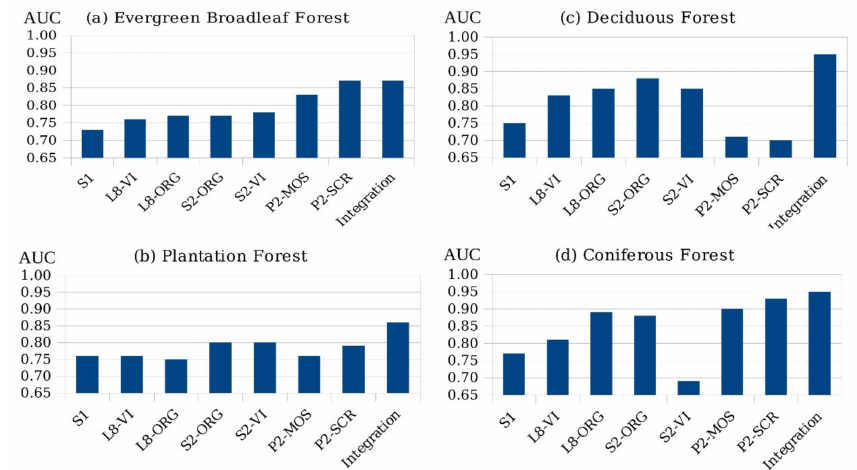
Figure 5. Comparison of the area under the curve (AUC) value of input data in forest classes. ( a ) The AUC value of input data in evergreen broadleaf forests; ( b ) The AUC value of input data in plantation forests; ( c ) The AUC value of input data in deciduous forests; ( d ) The AUC value of input data in coniferous forests where: S1 is the Sentinel-1 time-series; L8-VI is the Landsat 8 vegetation indices time-series; L8-ORG is the Landsat 8 original bands time-series; S2-ORG is the Sentinel-2 original bands time-series; S2-VI is the Sentinel-2 vegetation indices time-series; P2-MOS is the PALSAR-2 mosaic; P2-SCR is the PALSAR-2 / ScanSAR time-series; integration is the integration of all